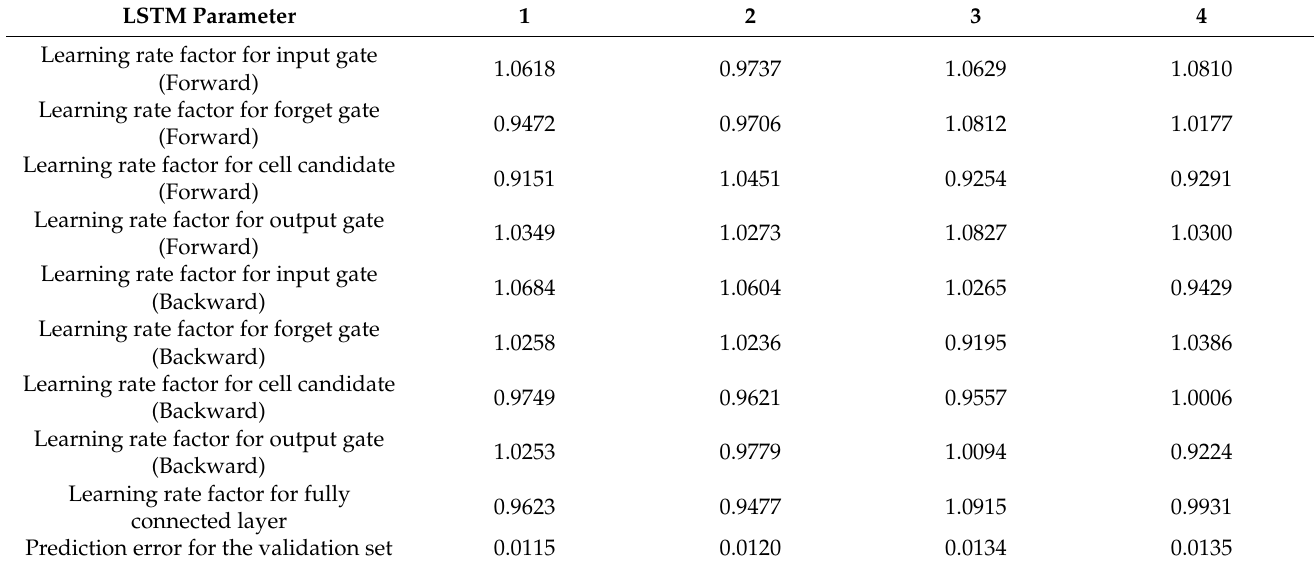
Table 3. The values of LSTM parameters in the four evaluations of BA (artificial porosity